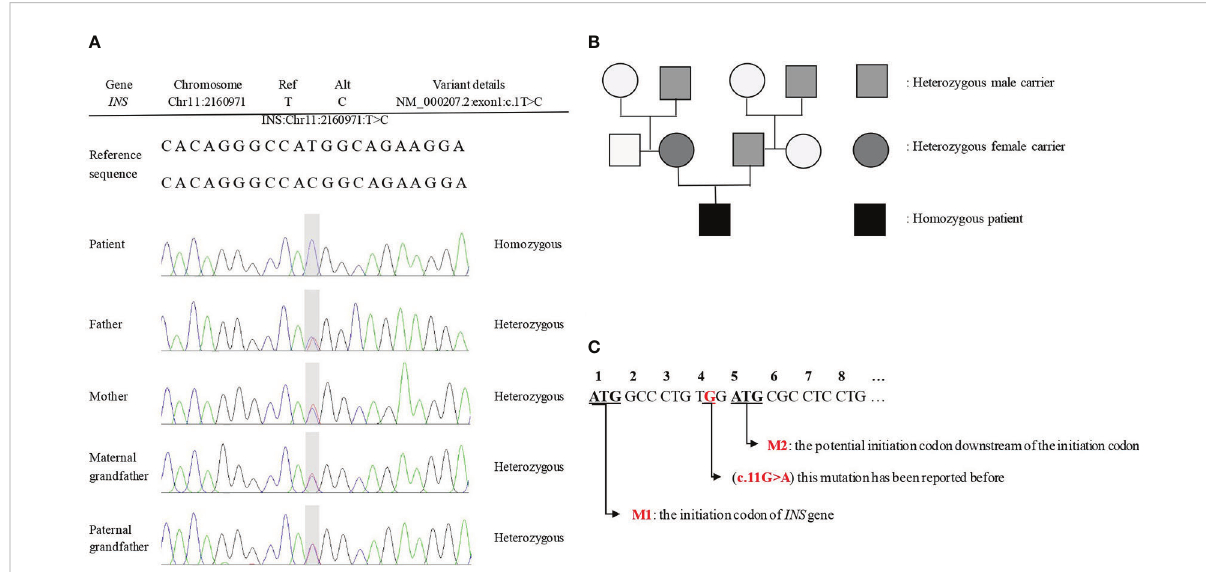
FIGURE 1 The results of Sanger sequencing and family pedigree. (A) The Sanger sequencing showed a novel mutation c. 1T>C (p.M1V) in the INS gene. (B) The family pedigree. The proband's parents and grandfathers are all heterozygous mutations at the locus, but none of them shows decreased glucose tolerance. (C) The transcript of INS